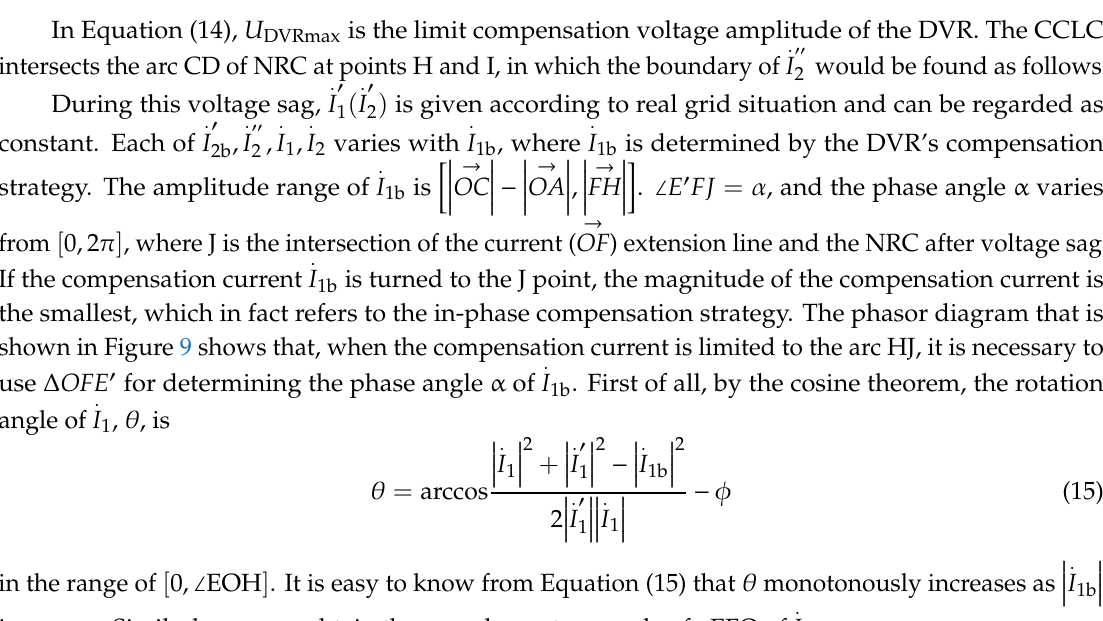
Figure 9. Phasor diagram of the external compensation range.